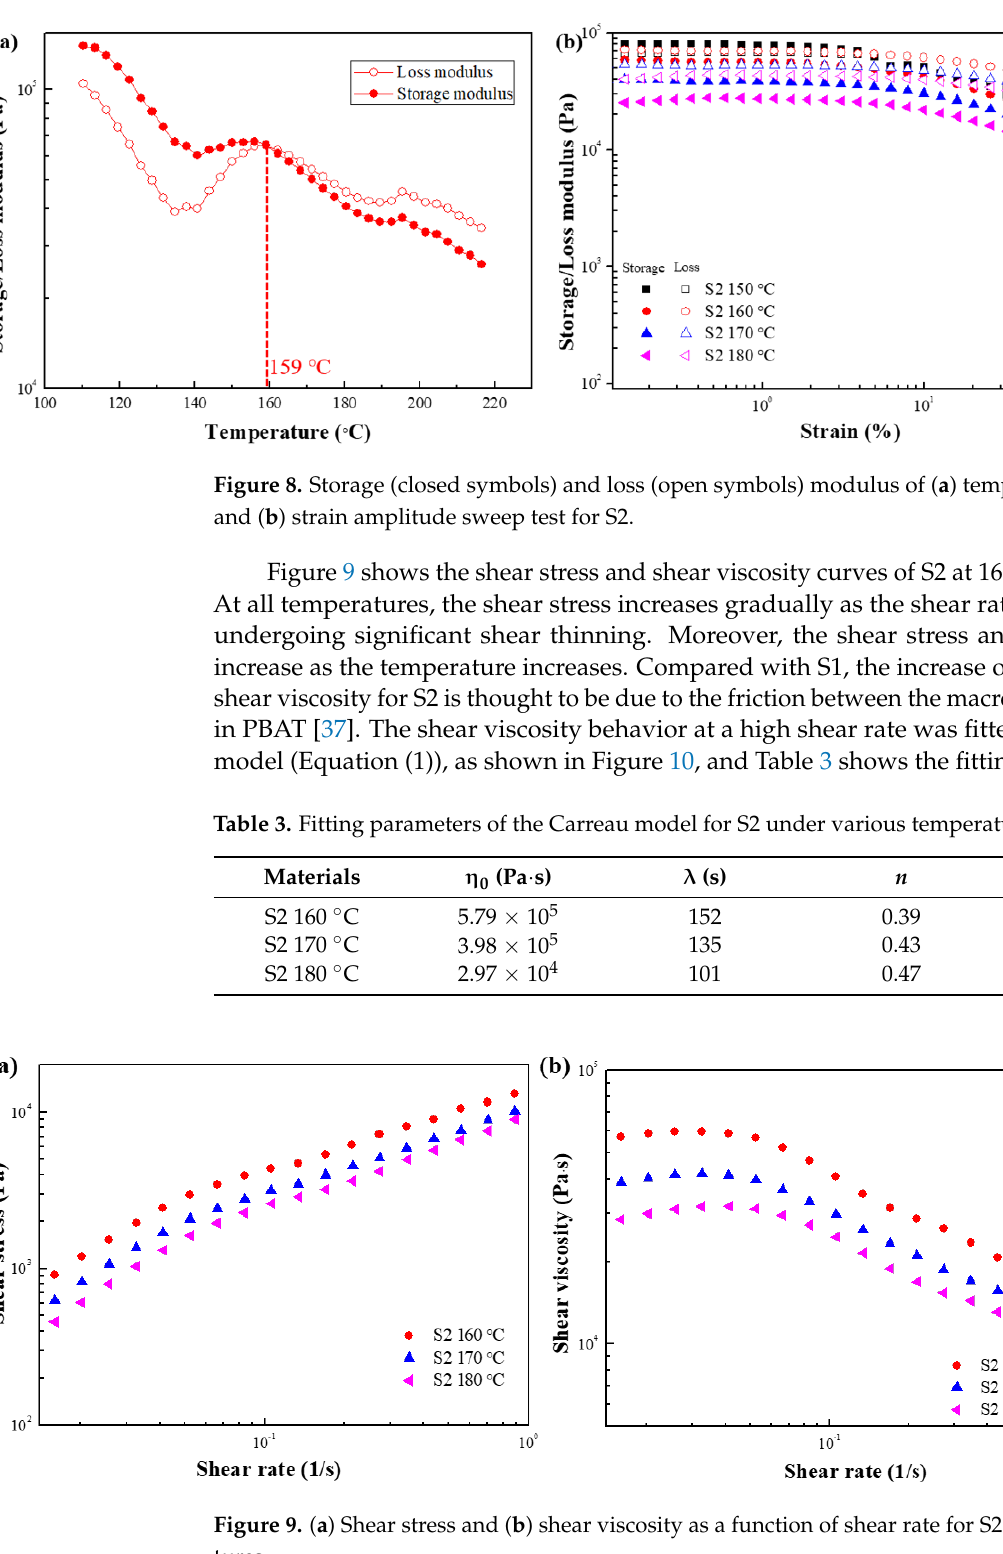
Figure 9. ( a ) Shear stress and ( b ) shear viscosity as a function of shear rate for S2 at various temper- atures.